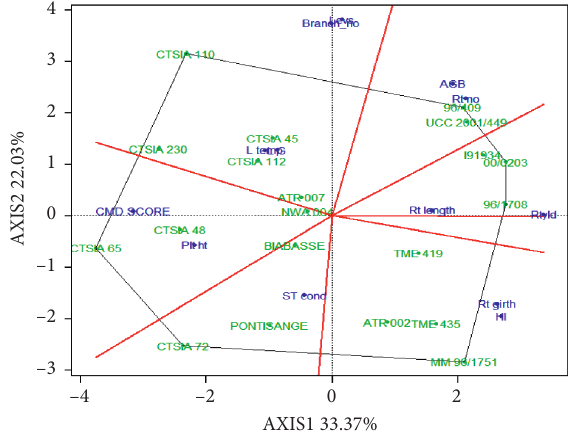
Figure 2: The “which won where” view of the genotype × trait biplot analysis of physiological traits of 20 genotypes of cassava among all traits in six environments. AGB � above ground biomass yield (t ha − 1 ), Branchno_plt � number of branches per plant, CMD (1–5) � cassava mosaic virus disease score (1 � healthy plant